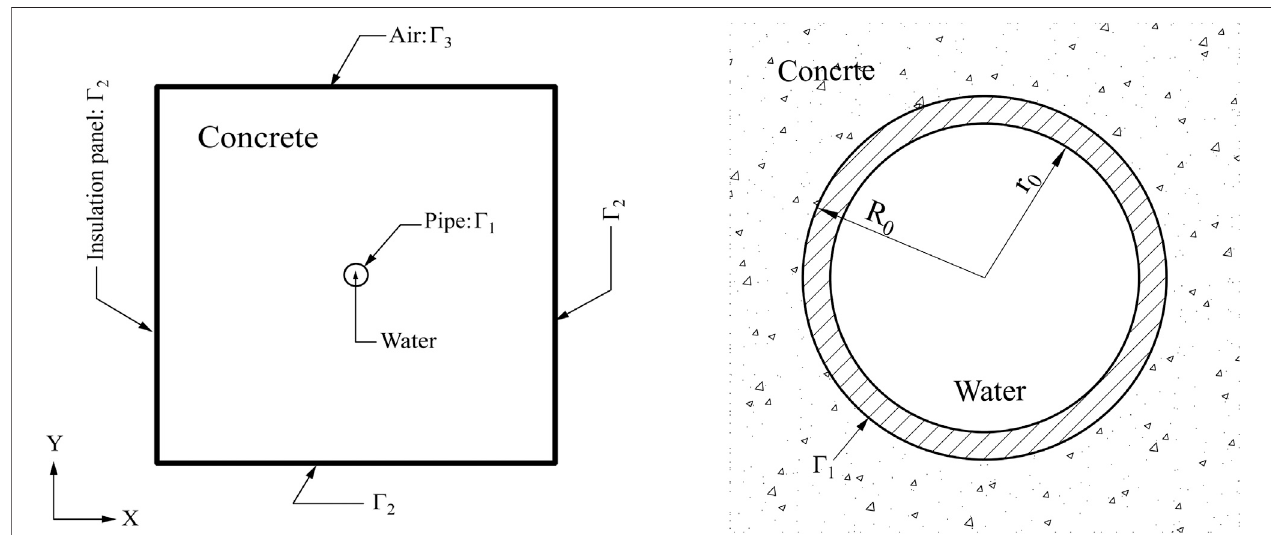
FIGURE 1 | Calculation model for water-containing